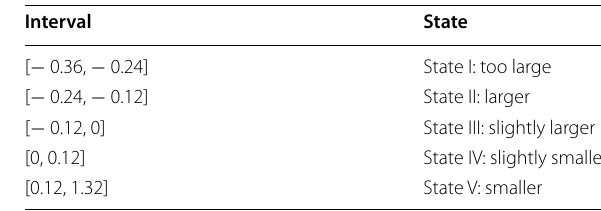
Table 4 State division of residual error value